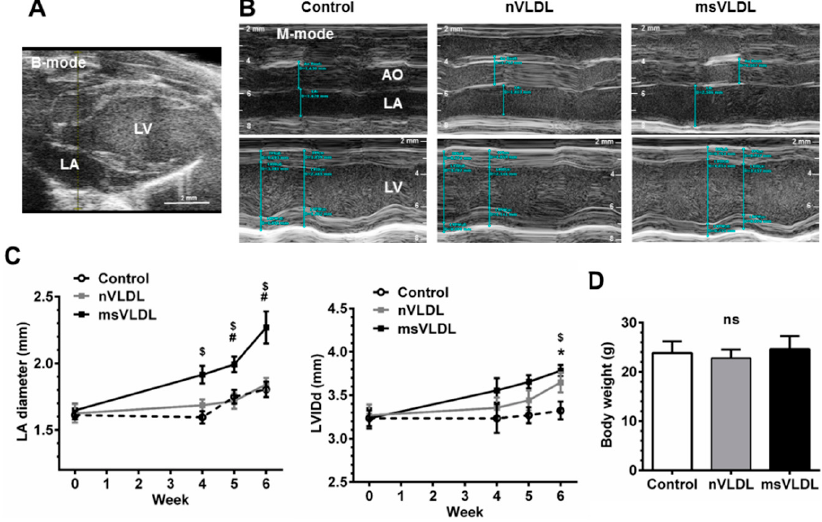
Figure 2. Both VLDLs caused LV dilation but only MetS-VLDL caused left atrial dilation. ( A ) Echocardiography of murine heart. Left atrium (LA) and left ventricle (LV) were identified in B-mode; ( B ) M-mode images for measurements of diameters of aortic root (AO), LA and LV. LA was significantly enlarged in the MetS-VLDL injection group (msVLDL) ( n = 6) but not in the normal-VLDL injection group (nVLDL) ( n = 7) or the control group ( n = 5); ( C ) Significant LA enlargement developed as early as 4–6 weeks after injection in the msVLDL group. LV dilatation developed significantly until 6 weeks. (msVLDL vs. control, $ p < 0.05; msVLDL vs. nVLDL, # p < 0.05; nVLDL vs. control, * p < 0.05); ( D ) No significant difference in body weight of the groups.